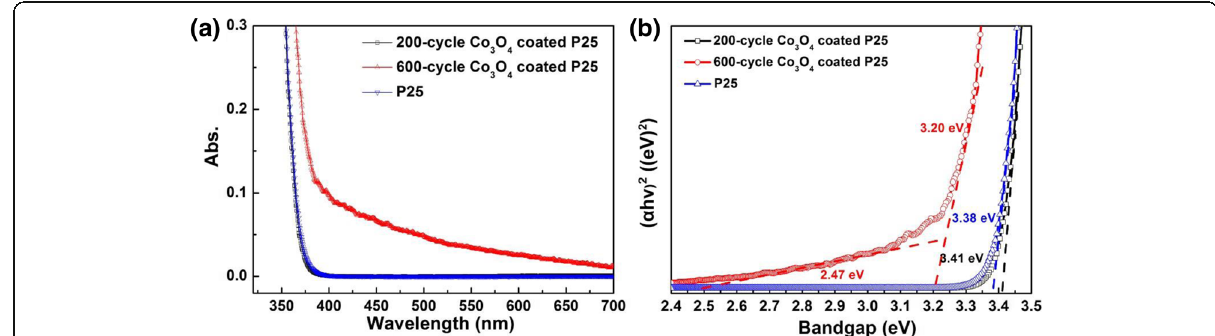
Fig. 4 a UV-visible diffuse reflection spectra and ( b ) corresponding band gaps determination plots of pure P25, 200-cycle and 600-cycle Co 3 O 4 -coated P25